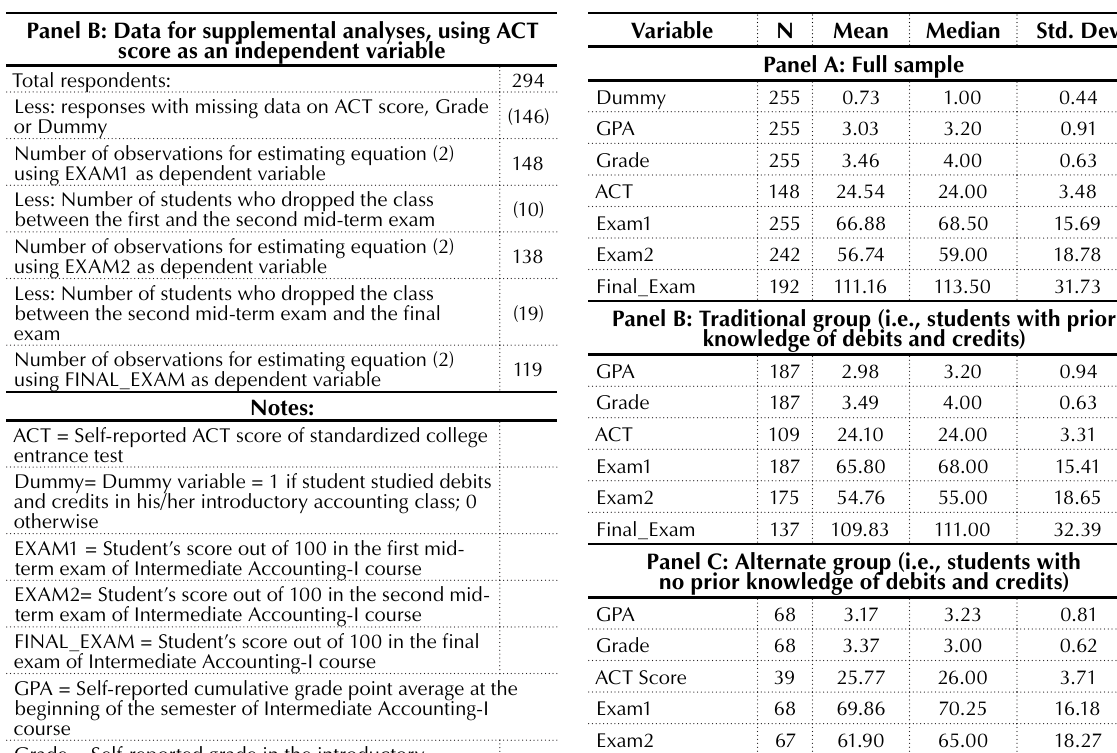
Table 1 (cont.). Data collection Table 2. Summary